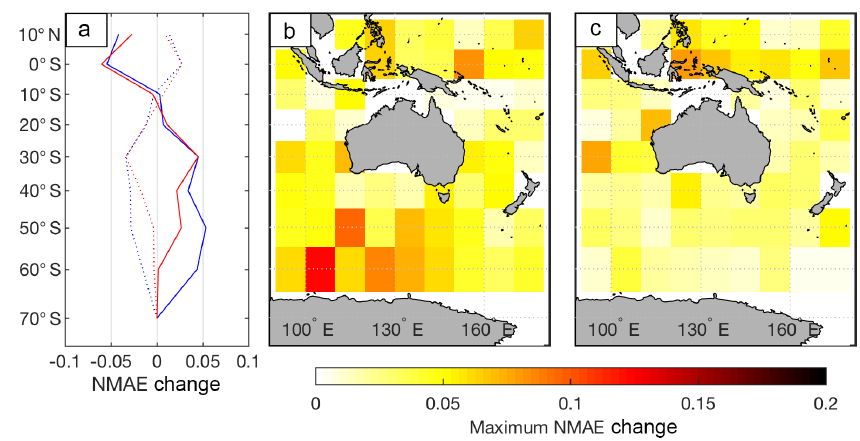
Figure 10. (a) The change of the NMAE in MLD when the temperature and salinity thresholds are varied by + 50% (dotted) and − 50% (solid), for OceanMAPS version 2.2.1 (blue) and 3.0 (red). The maximum absolute change in NMAE recorded for a ± 50% change in thresholds is shown in 10 ◦ × 10 ◦ latitude and longitude bins for version 2.2.1 (b) and 3.0 (c) are also